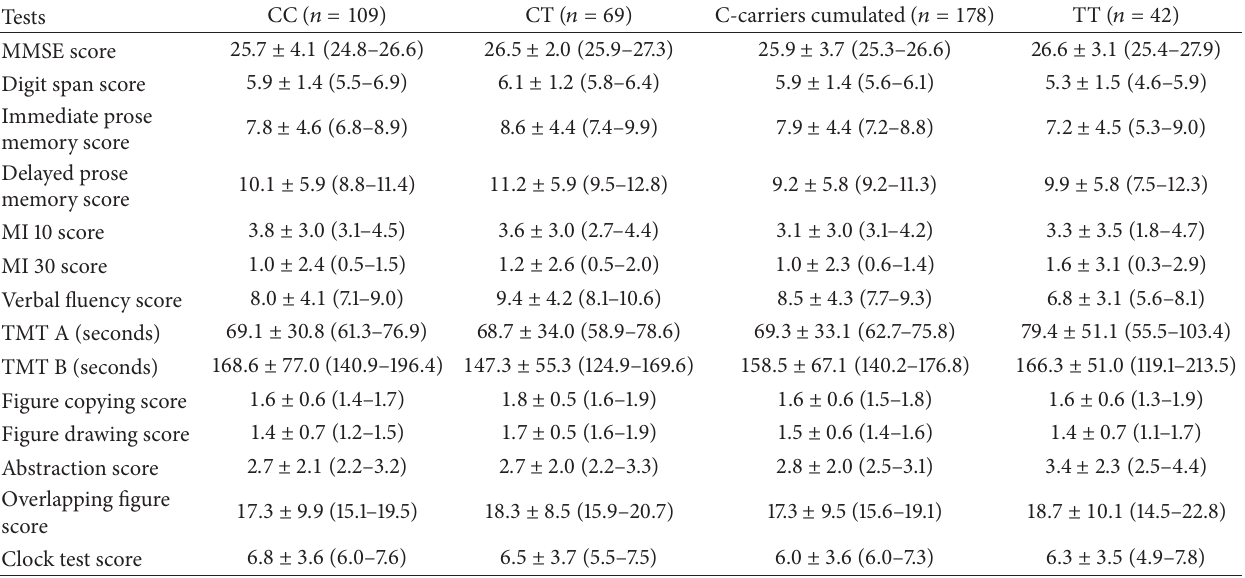
Table 4: Unadjusted values of the score of the neuropsychological tests across the C825T polymorphism of GNB3 gene. The C-carriers were also